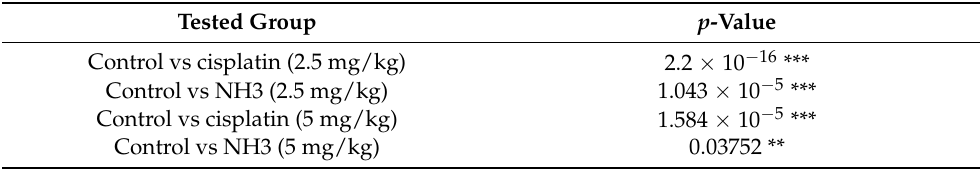
Table 5. Observed p -values from Satterthwaite’s method for equality of variances. Tested Group